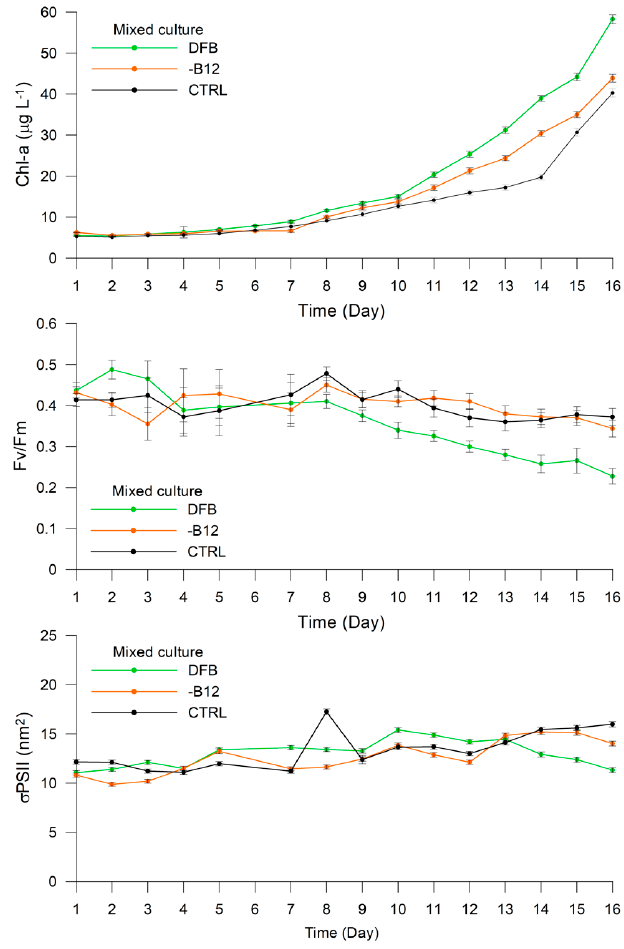
Figure 5. Experiment 1. Changes in Chl-a concentration ( µ g L − 1 ), Fv / Fm, and σ PSII (nm 2 ) in the mixed culture of Phaeocystis antarctica and Prorocentrum sp. under different treatments.